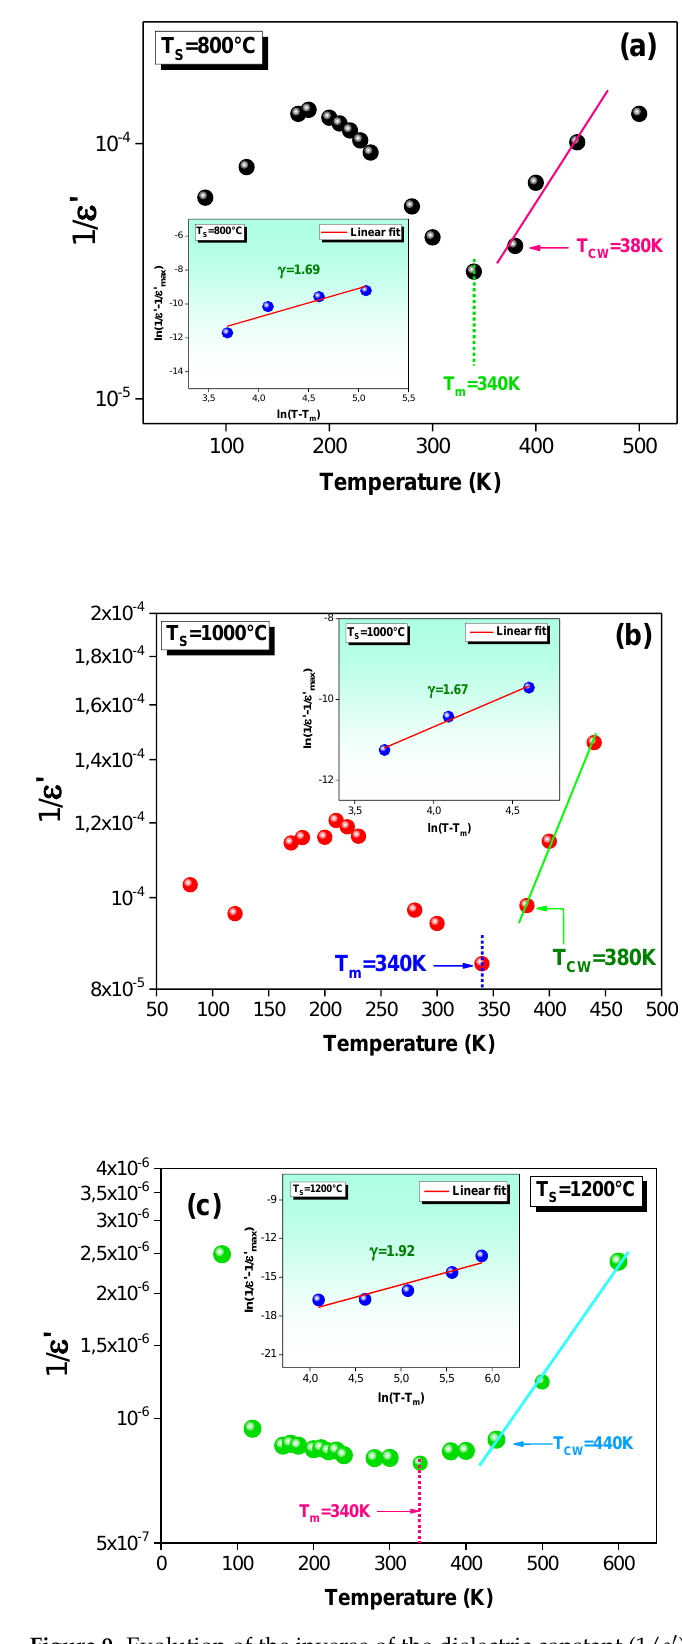
Figure 9. Evolution of the inverse of the dielectric constant (1/ ε (cid:48) ) as a function of temperature for the La 0.9 Sr 0.1 MnO 3 system sintered at ( a ) 800, ( b ) 1000 and ( c ) 1200 ◦ C. The insets are the plots of ln((1/ ε (cid:48) ) − (1/ ε (cid:48) max)) against ln(T − Tm) for each